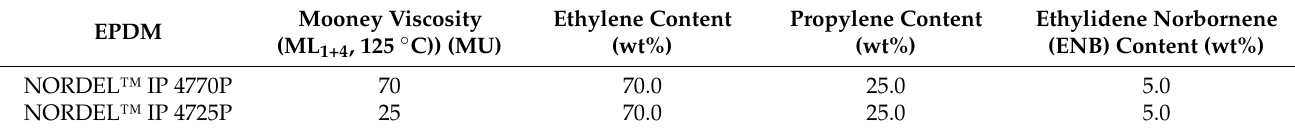
Table 1. The physical information of